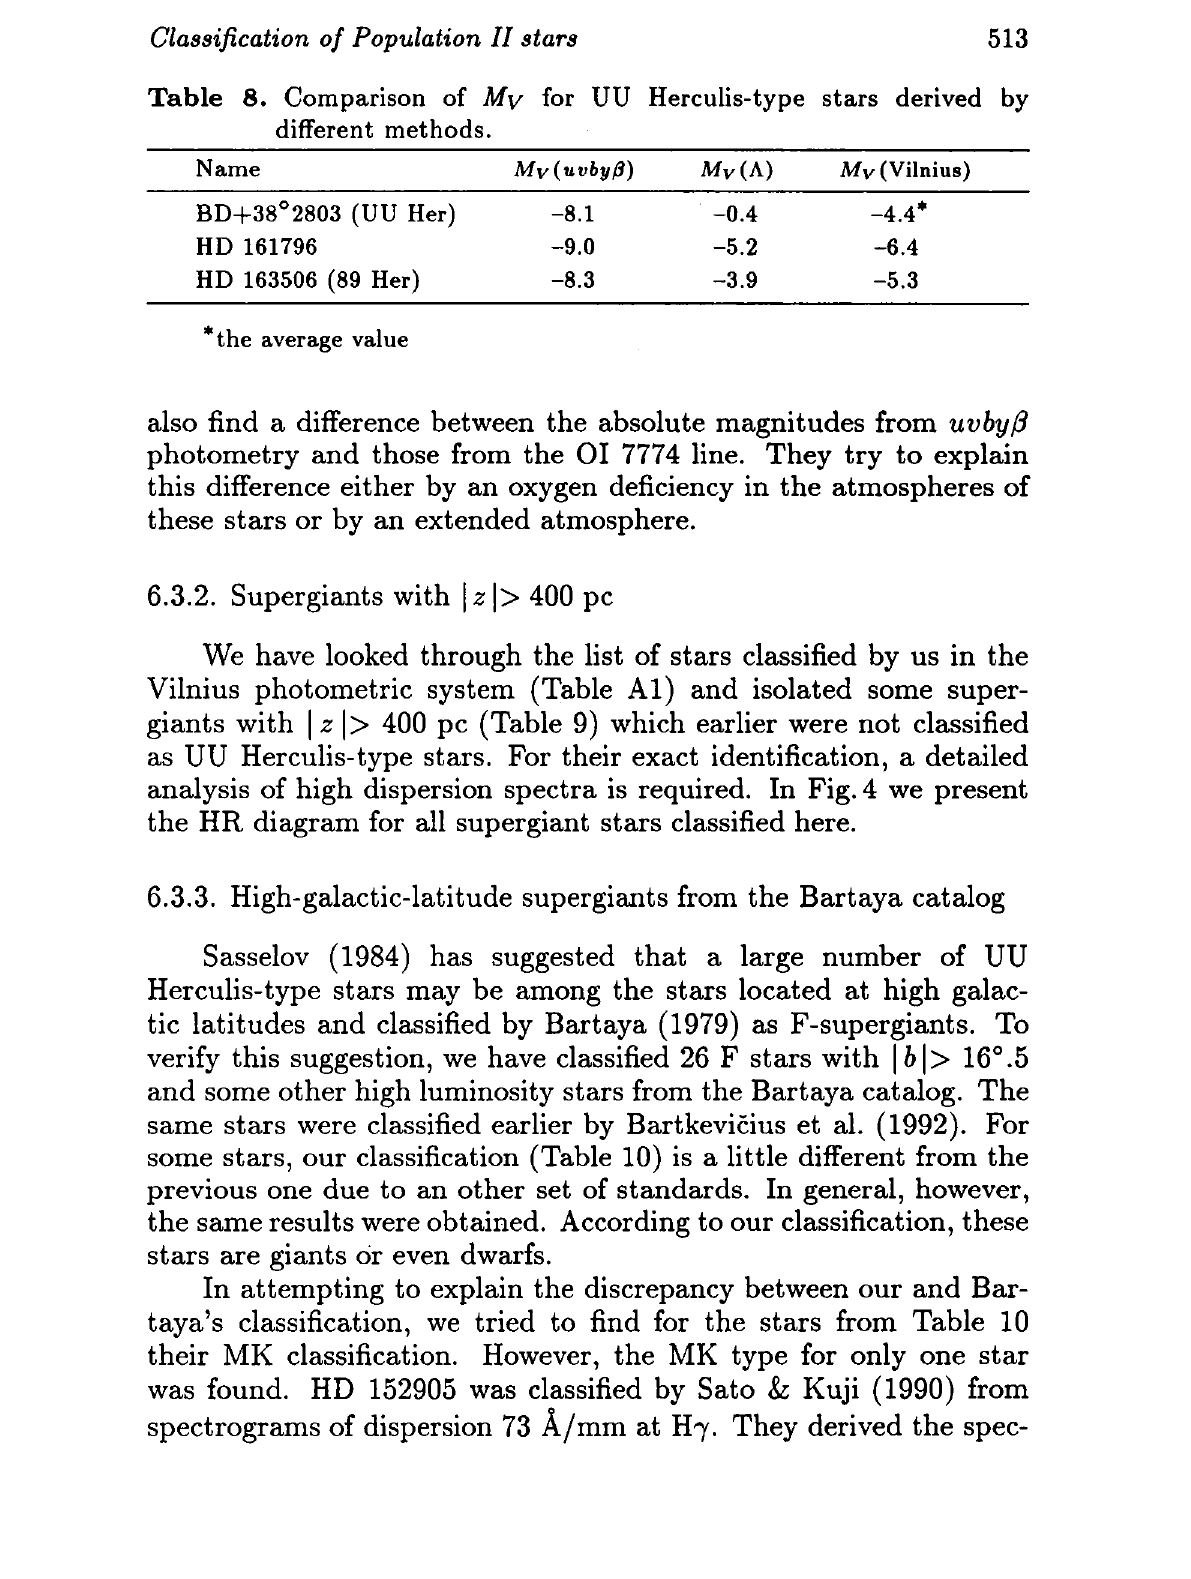
Table 8. Comparison of My for UU Herculis-type stars derived by different